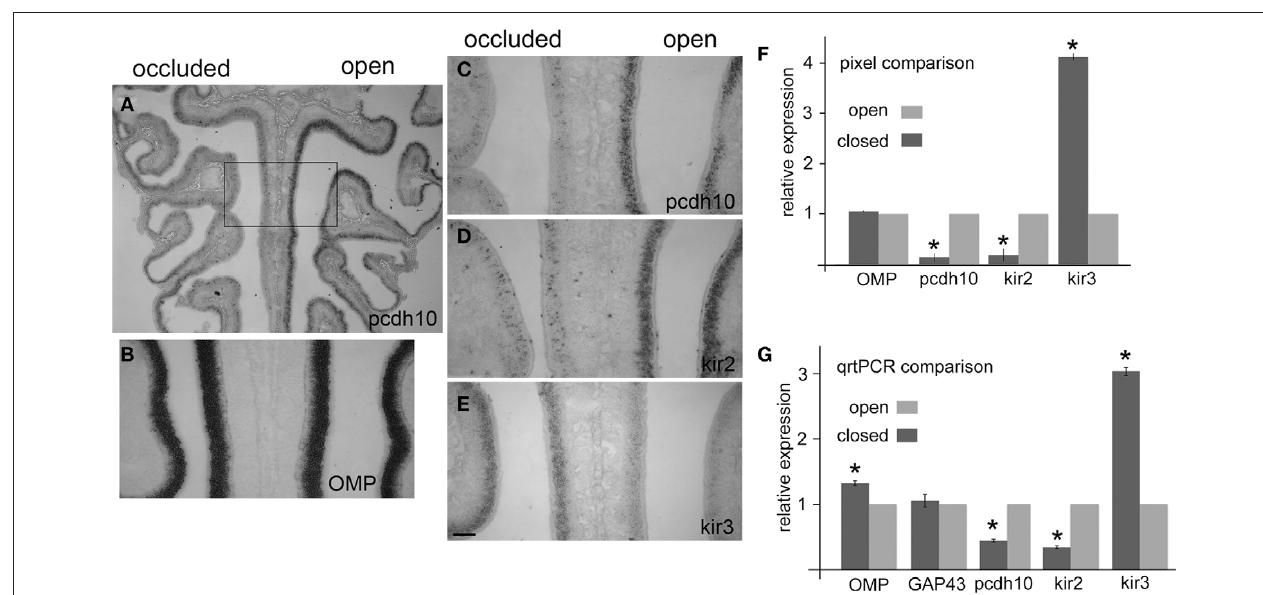
significantly up-regulated. OMP expression was unaffected. OMP ( p = 0.08); pcdh10 , kirrel2 , kirrel3 ( p < 0.005), (g) Epithelia from six occluded animals were split in half. Quantitative RT-PCR was performed to compare expression of each half-epithelium from the occluded naris against the corresponding half-epithelium from the open naris. Expression of OMP was slightly (1.3 × ) higher in the occluded side relative to the open side ( p < 0.005). GAP43 was unchanged ( p = 0.98). Pcdh10 expression on the occluded side was ∼ 50% of the open side ( p < 0.005), similar to kirrel2 (35% of open side; p < 0.005). Kirrel3 was increased three-fold on the occluded relative to the open side ( p < 0.005). Scale bar = 250 μm (A) 100 μm